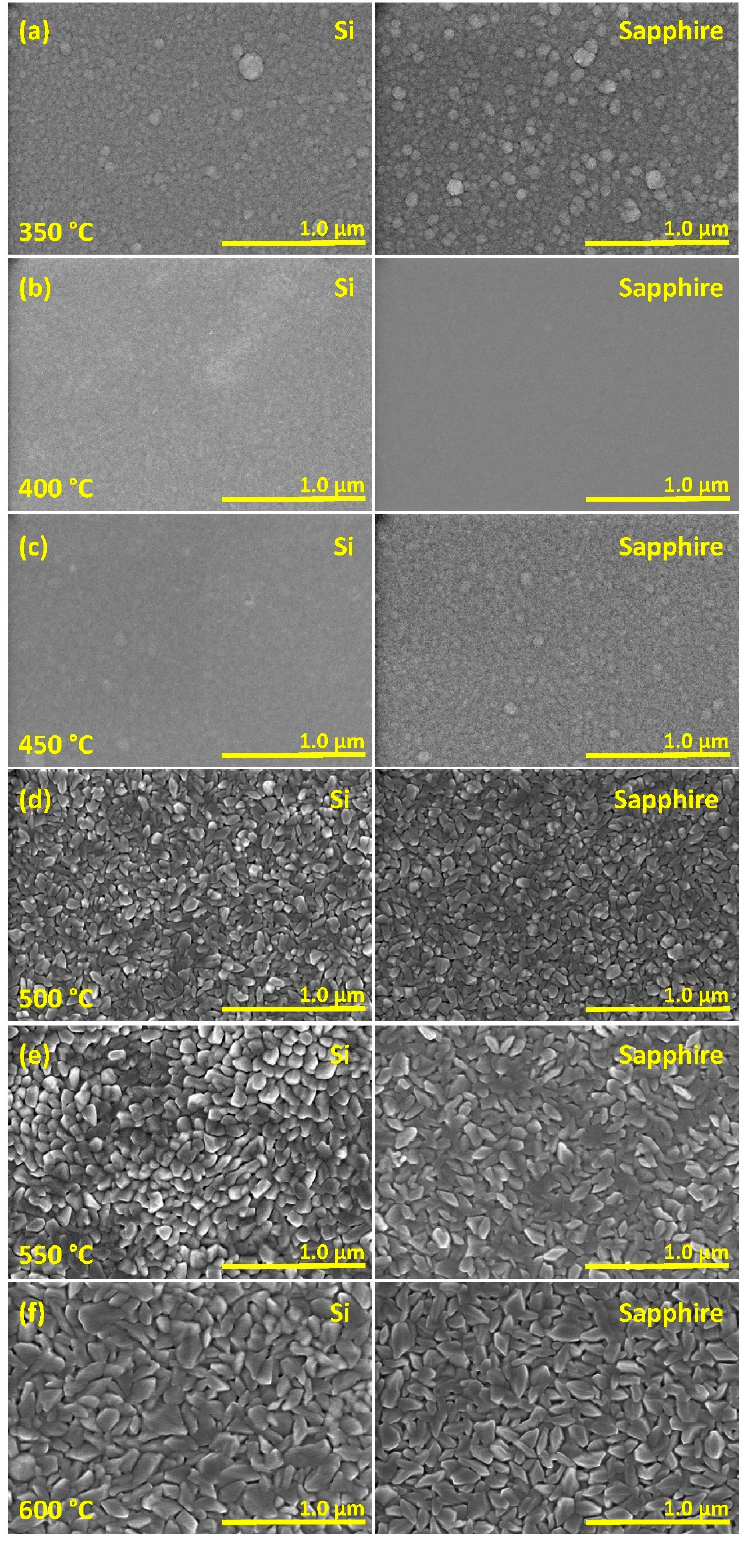
Figure 3. Surface images of VO 2 and V 2 O 5 thin films prepared at various substrate temperatures ( T S